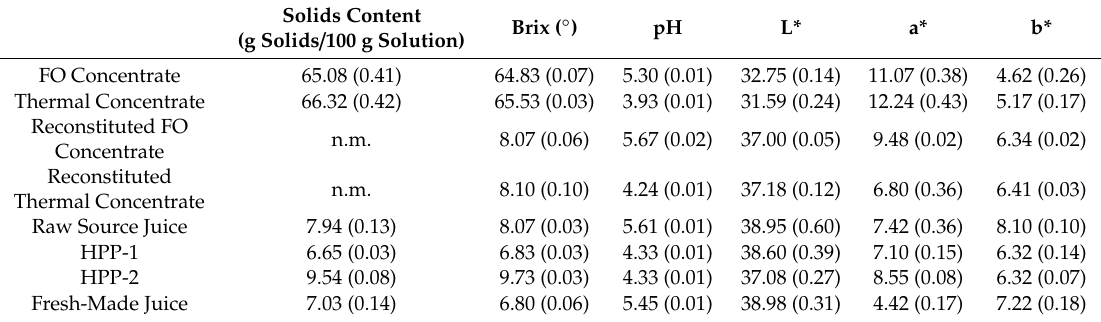
Table 1. Physicochemical properties of watermelon juice concentrates and watermelon